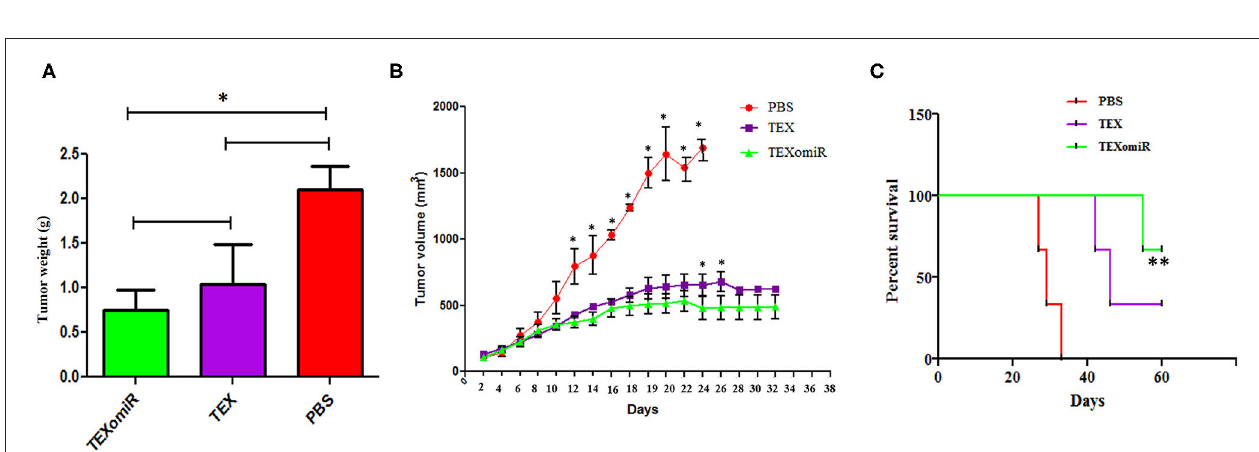
FIGURE 6 | The anti-tumor efficiency of TEXs and TEXomiR in female BALB/c mice bearing CT-26 colon tumor. (A) The tumor weights in mice treated with TEXomiR were significantly different from those of phosphate-buffered saline (PBS)-treated mice. (B) Inoculation with TEX or TEXomiR significantly inhibits tumor growth. (C) The mice treated with TEXomiR had a significantly longer survival rate than PBS-treated mice or those treated with TEXs. The data are presented as mean ± SD. ** P < 0.01, * P < 0.05. One-way ANOVA was used to make comparisons between groups. TEXomiR, miR-124-3p-enriched TEXs; TEXs, tumor exosomes.